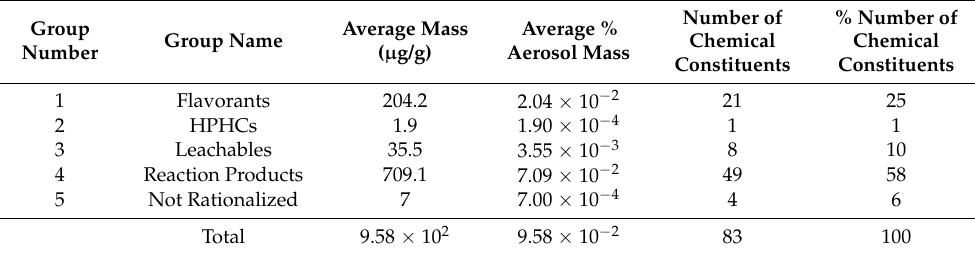
Table 7. Summary of non-targeted analyses in Me5 aerosol detected by GC and LC NTA methods using the intense puffing regimen.